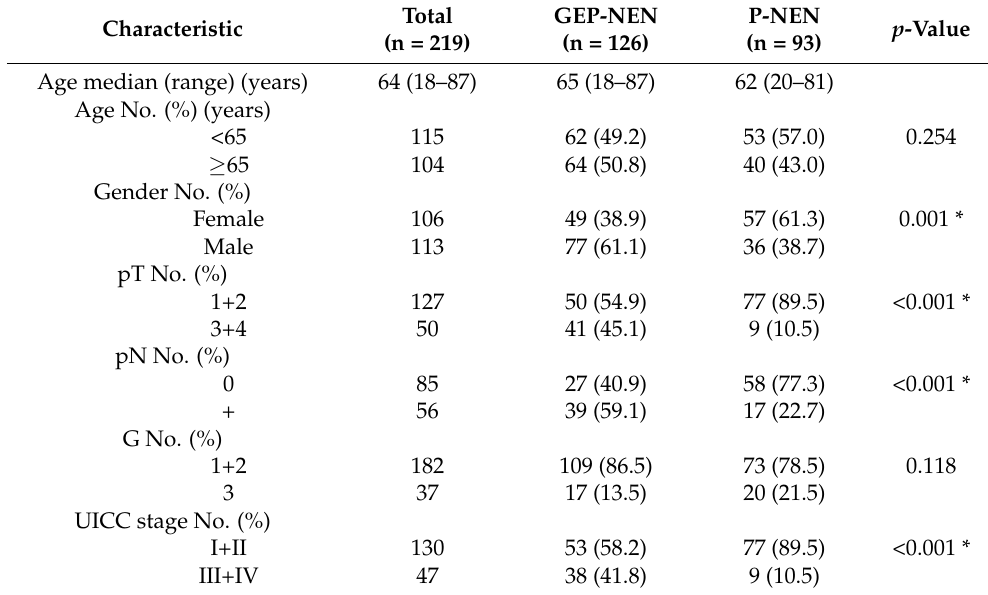
Table 1. Characteristics of enrolled patients. GEP: gastroenteropancreatic, NEN: neuroendocrine neoplasia, P: pulmonary, UICC: Union international contre le